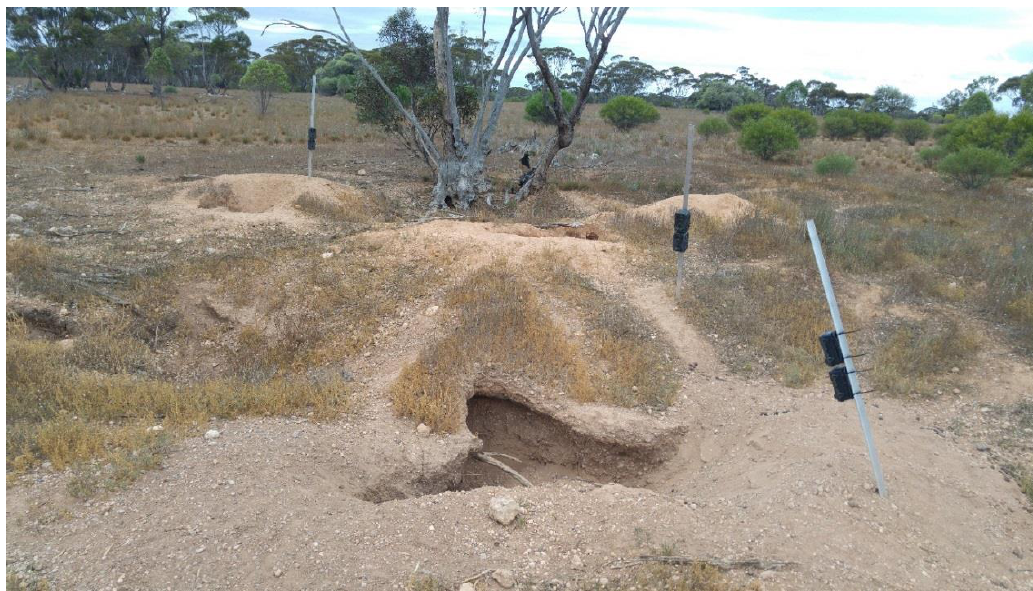
Figure 2. Camera set-up at Site #5, Moorunde Wildlife Reserve. Each pole has two cameras — one still and one video (six cameras total at each site), with all cameras aimed at the burrow crater in the foreground. The close-up cameras are on the right side of the image, the medium-range are in the centre, and the long-range cameras are on the left.